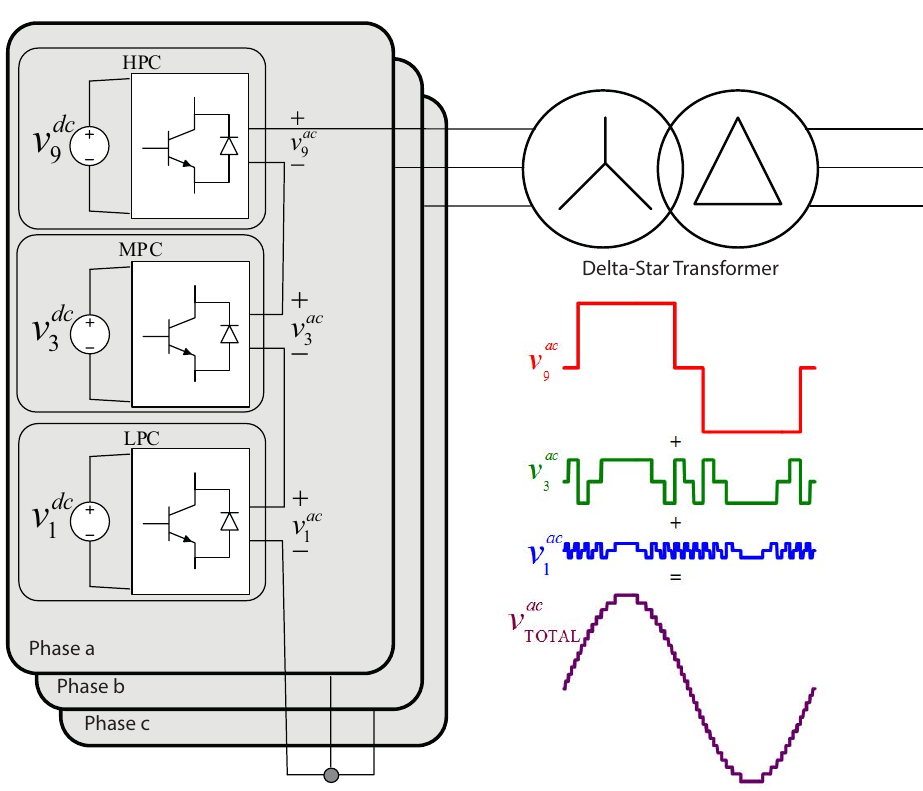
Figure 1. 27-level asymmetric multilevel converter (HPC: high power cell, MPC: medium power cell, LPC: low power cell). Figure 1. 27-level Asymmetric Multilevel Converter (HPC: High Power Cell, MPC: Medium Power Cell, LPC: Low Power Cell).